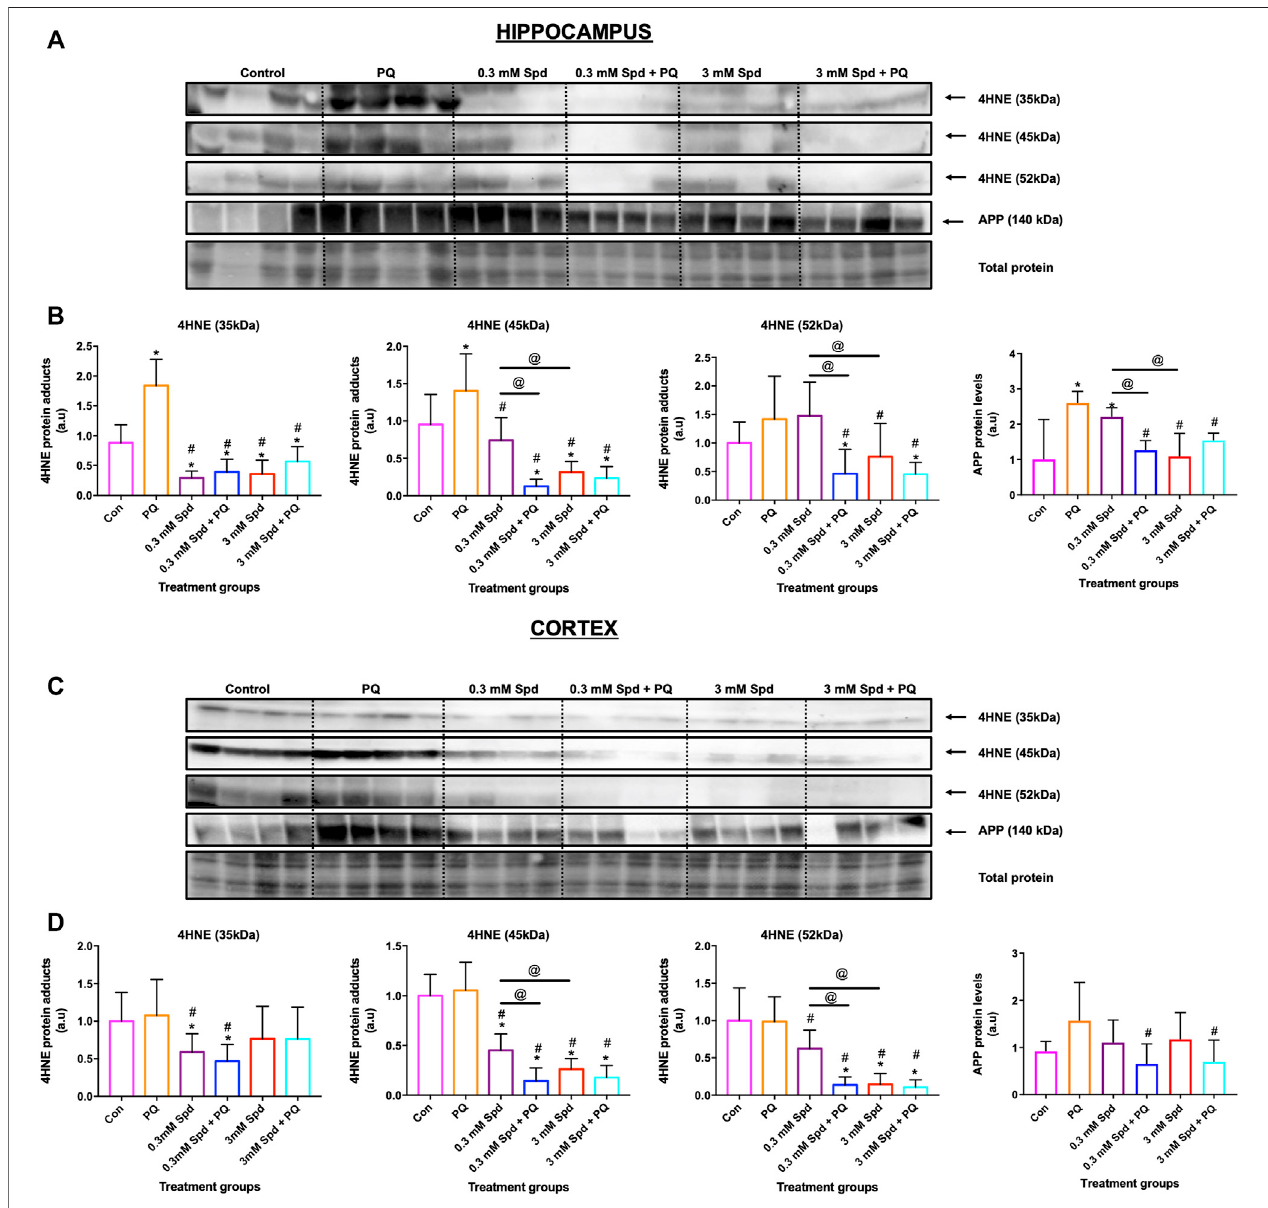
FIGURE 10 | Spermidine reduces lipid peroxidation and amyloidogenic processing in the hippocampus and cortex region. Representative western blot and densitometric analysis of 4HNE adducts (35, 45 and 52 kDa) and APP protein levels in the hippocampus (A and B) and (C and D) cortex. The data are expressed as mean±SEM.Atotalof6 – 10animalswereusedpergroup( n =6 – 10).SpermidineincombinationwithPQreduced4HNEandAPPproteinlevelscomparedtoPQtreated group. * = p < 0.05 vs. control, # = p < 0.05 vs. PQ and @ = p < 0.05 vs. 0.3 mM Spd, arbitrary units (a.u).